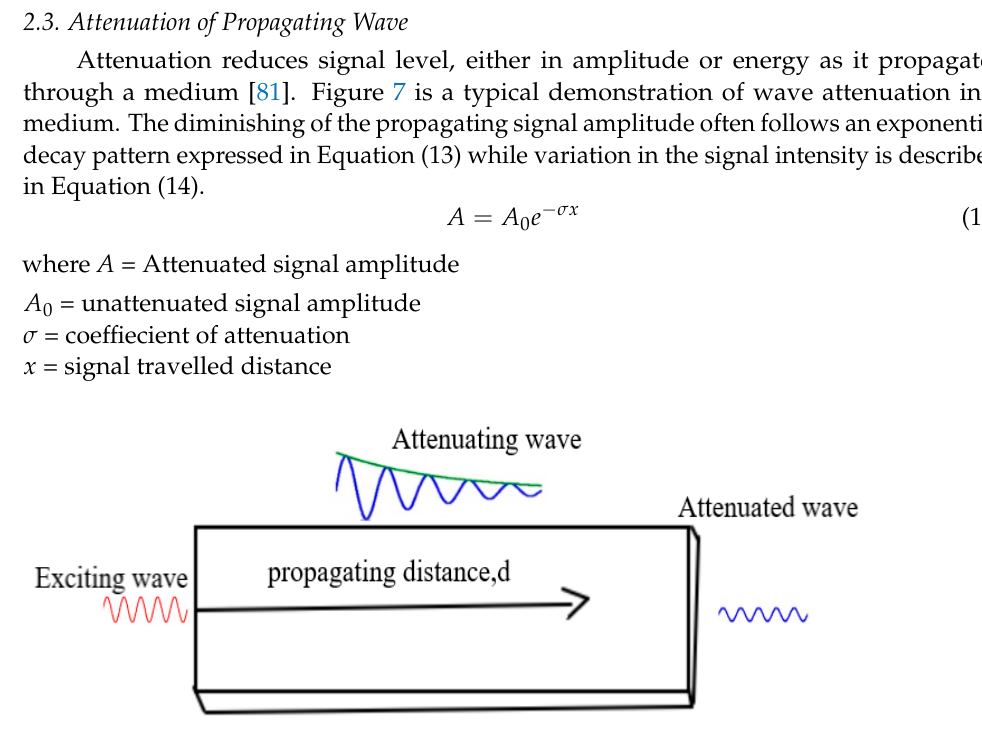
Figure 7. Signal attenuation in a medium.